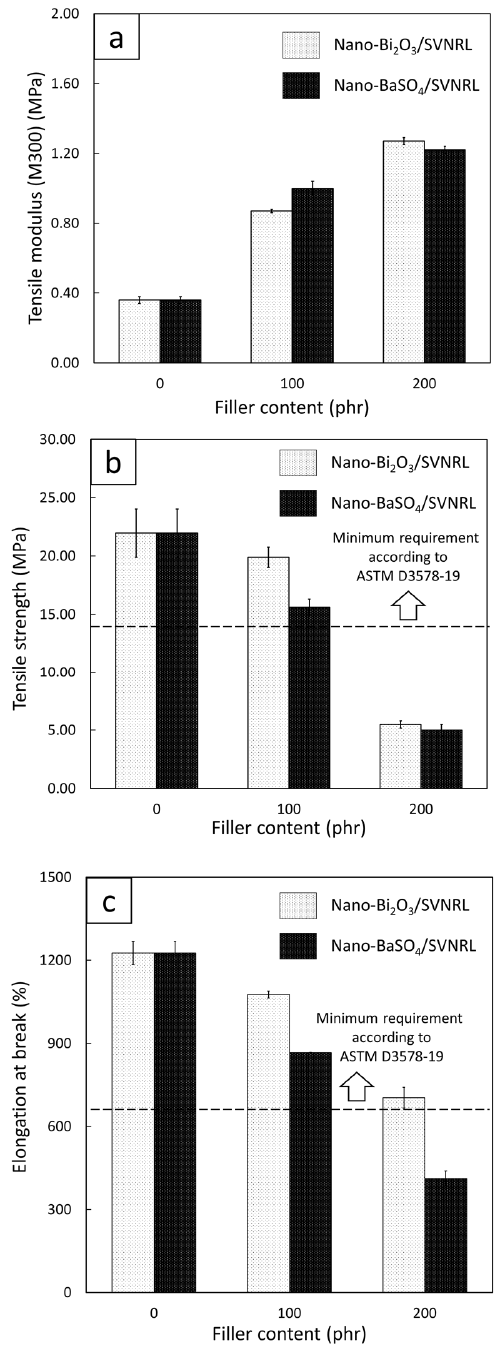
Figure 7. ( a ) Tensile modulus at 300% elongation (M300), ( b ) tensile strength, and ( c ) elongation at break of nano-Bi 2 O 3 /SVNRL and nano-BaSO 4 /SVNRL composites. The dotted lines in ( b ) and ( c ) represent the minimum requirements for tensile strength and elongation at break, respectively, for medical examination gloves according to ASTM D3578-19.